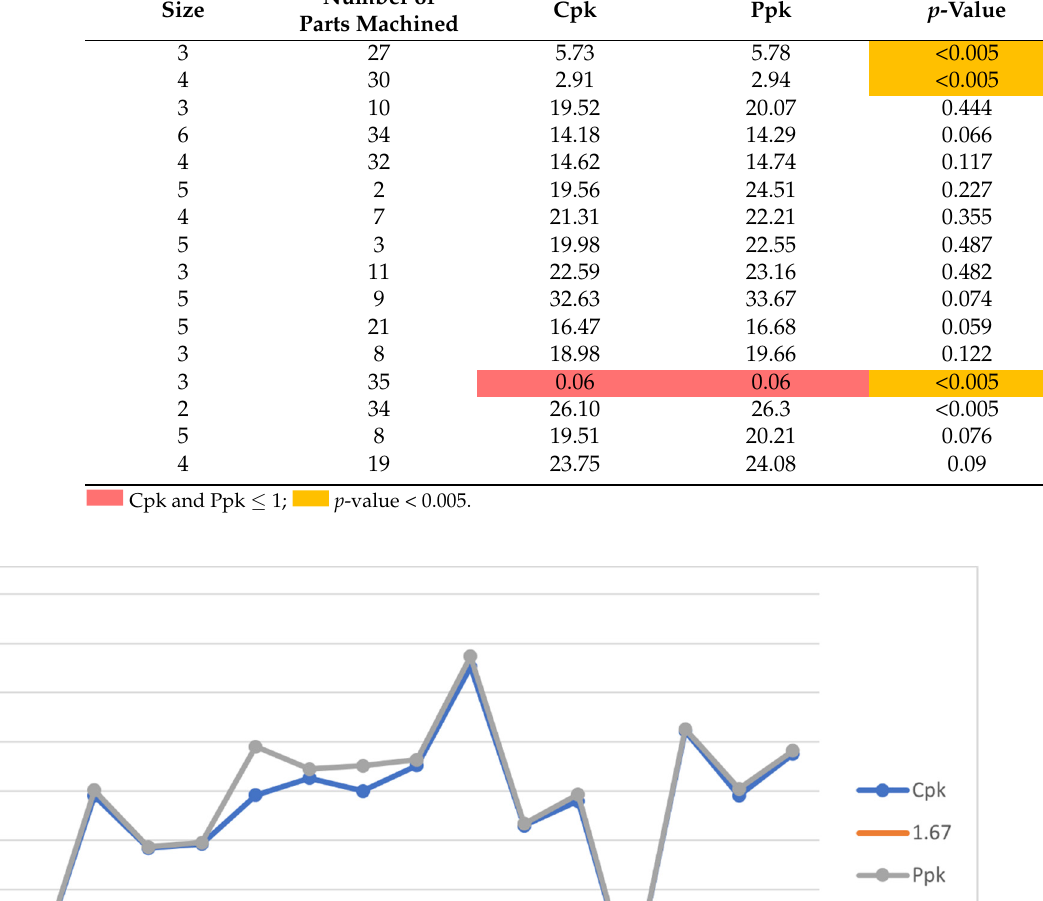
Figure 13. Plot of capability index for all DIMs.